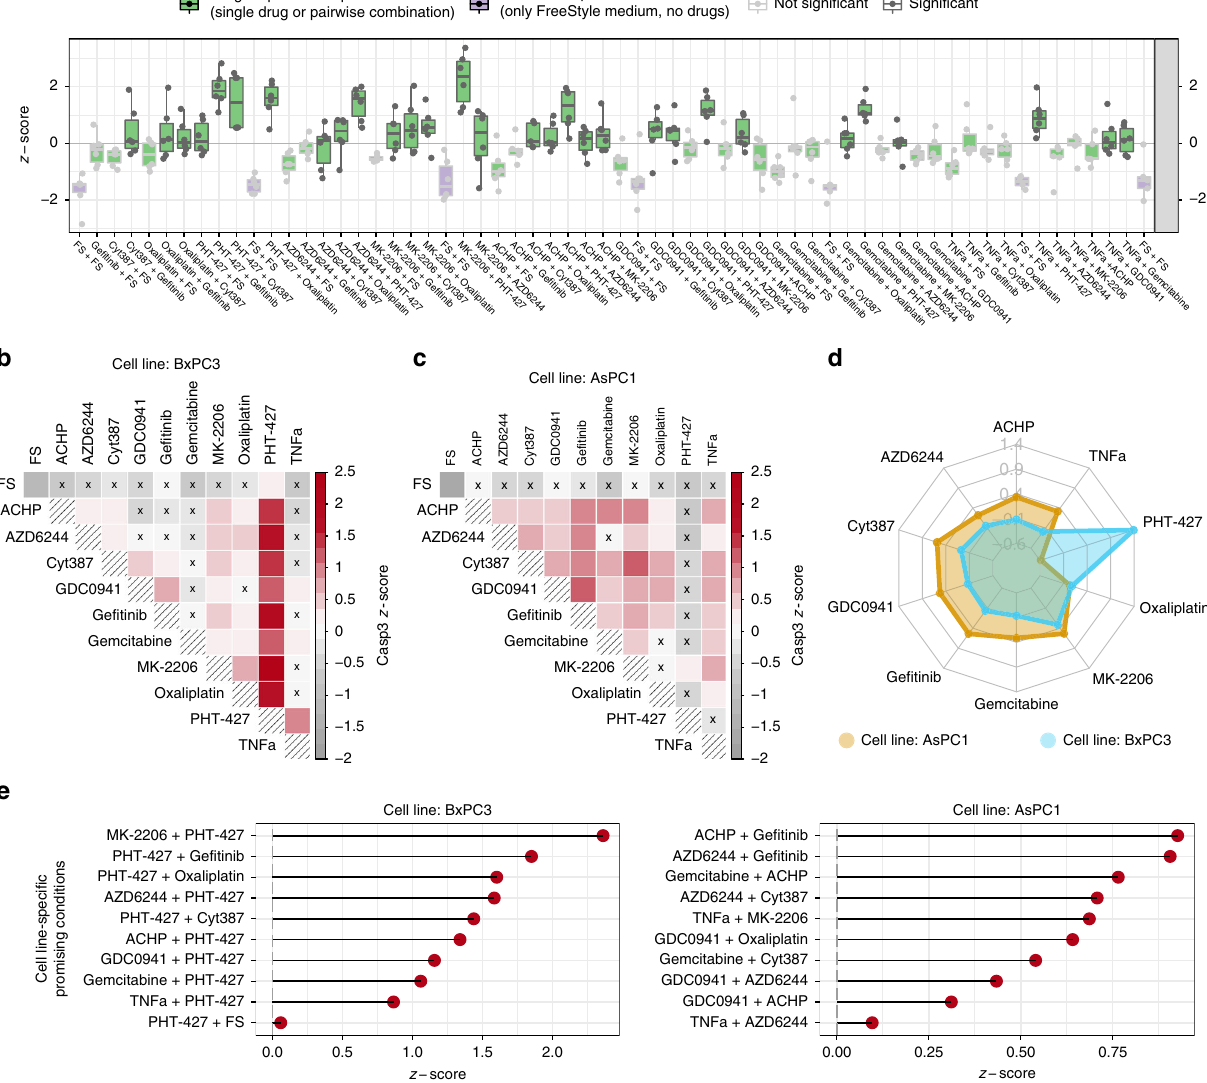
Fig. 3 Micro fl uidic combinatorial drug screening in cell lines. a Boxplot of the sequence of conditions across multiple replicates for BxPC3 cells ( z -scores of Caspase-3 activity) with control conditions in purple and conditions which are not signi fi cantly (Wilcoxon rank-sum test; p -value < 0.05) better than the control with light grey borders and dots. For each condition, replicates are shown as dots, and summary statistics are represented using a horizontal line for the median and a box for the interquartile range. The whiskers extend to the most extreme data point, which is no >1.5 times the length of the box away from the box. b Heatmap representation of the same conditions as in a (BxPC1 cell line) using median value across 6 replicates. Colored red scale starting from z -score equal to 0 (i.e., median activation across all conditions) while negative values are represented in grey. Conditions which are not signi fi cantly better than the control are marked with an x. c Heatmap representation for AsPC1 cells. d Overall drug ef fi cacy for each cell line, computed as median z - score across all conditions (single or combinatorial perturbations) involving the drug. e Top 10 cell line-speci fi c conditions for each cell